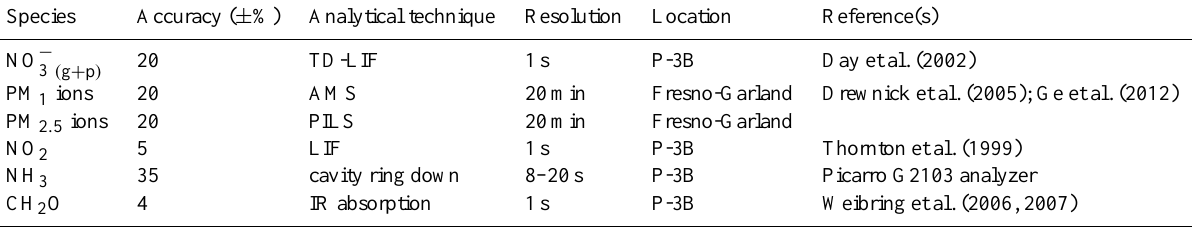
Table A1. Species, measurement accuracy, analytical technique, time resolution, location/platform, and reference for select DISCOVER-AQ observation included in our analysis. Many compounds are measured with higher precision than accuracy. See original references for details. Species